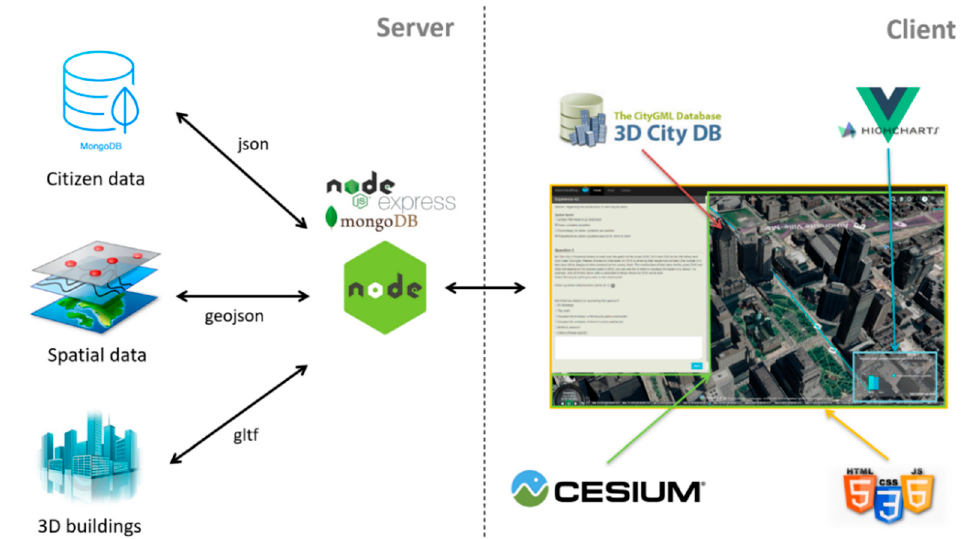
Figure 1. General software architecture.